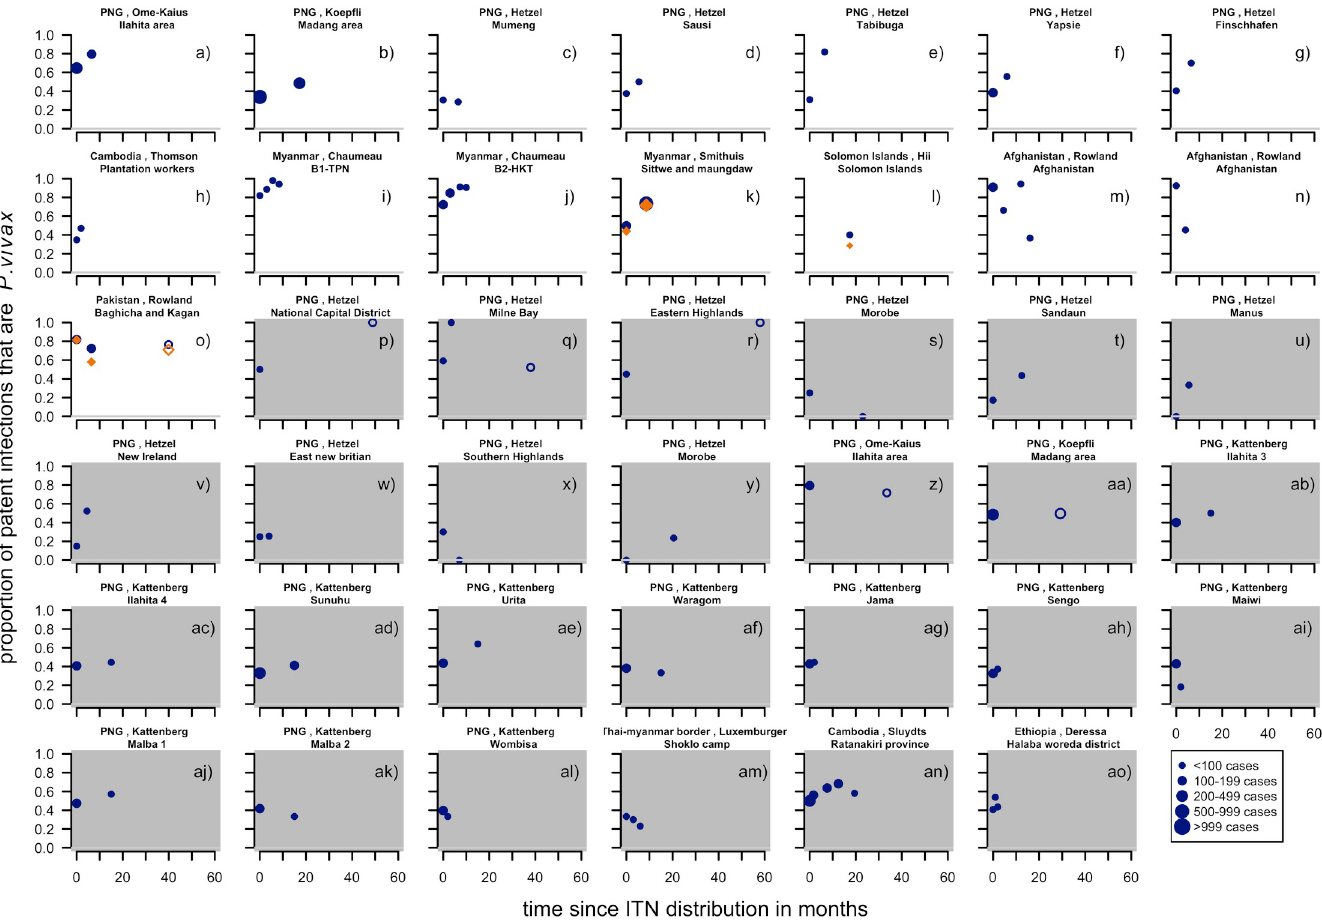
Fig 4. Proportion of patent infections that are P. vivax by time since first ITN distribution (white background) or repeated ITN distribution (grey background). Blue filled circles: proportion of cases attributed to P. vivax up to 24 months from the intervention. Orange diamonds: the proportions in the control groups. Dot size depending on number of infections found. Study p), r) and aa) are excluded from the regression analyses due to having no data collected in the first 24 months following the intervention. Pre-intervention points as described in Methods (definition of variables: time since implementation).